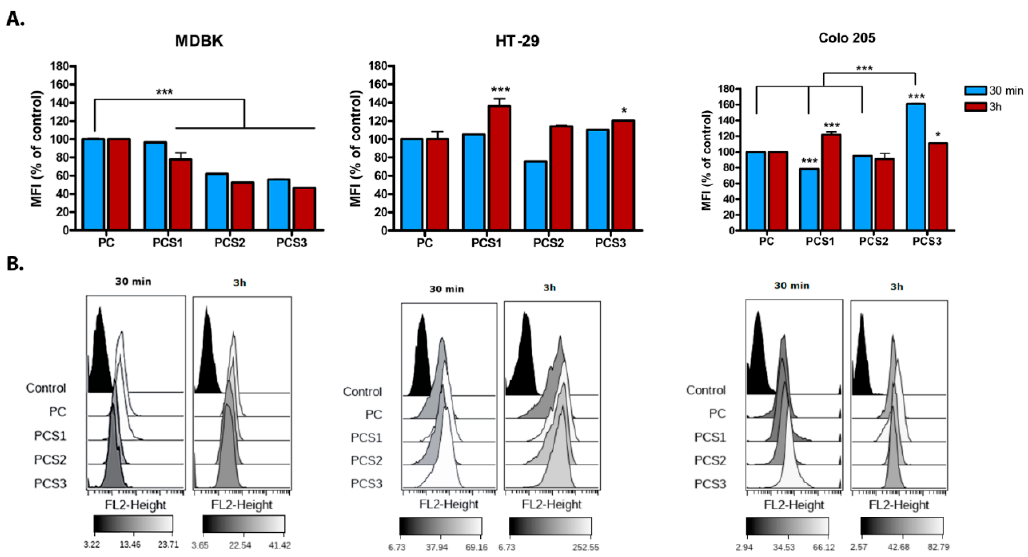
Figure 10. Flow cytometry for DOX released from nanocomposites systems and internalized into MDBK HT-29 and Colo 205 cells, after 30 min and 3 h of treatment. ( A ) Graphical representation; Mean fluorescent intensity (MFI) for PC control was set to 100%. ( B ) Histograms overlay and gray scale gradient of fluorescence representation using Cytobank; control-untreated cells. *** p value < 0.001; * p value <